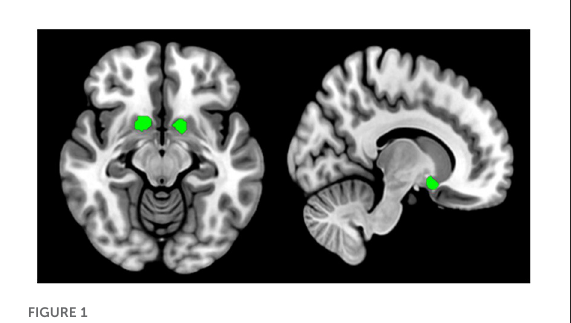
FIGURE1 Nucleus accumbent seed regions of interest are defined by the Anatomical Automatic Labeling (AAL3) atlas (https://www.oxcns. org/aal3.html). Bilateral nucleus accumbent seeds are used in resting-state functional connectivity analysis and gray matter volume